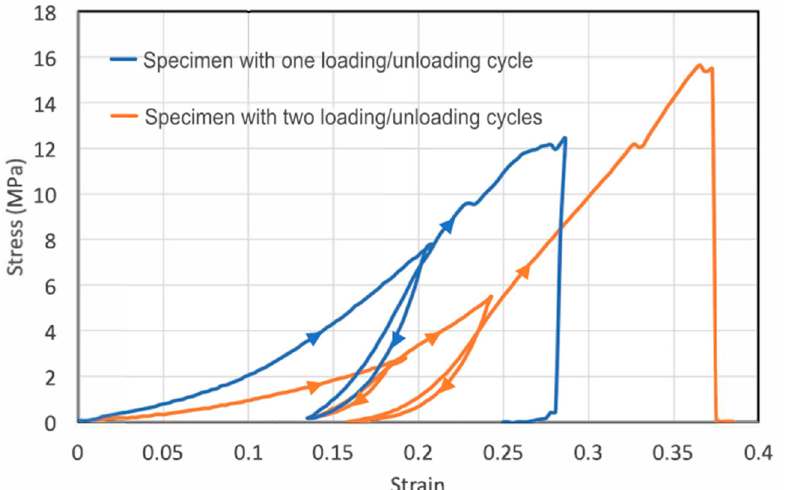
Figure 2. Cyclic loading of the skin strips showing the large plastic deformation and significant hysteresis. The first specimen (blue) was subject to one loading–unloading cycle before reloaded to failure, whereas the second specimen (orange) was subject to two loading–unloading cycles. The loading–unloading directions are indicated by triangular arrows.